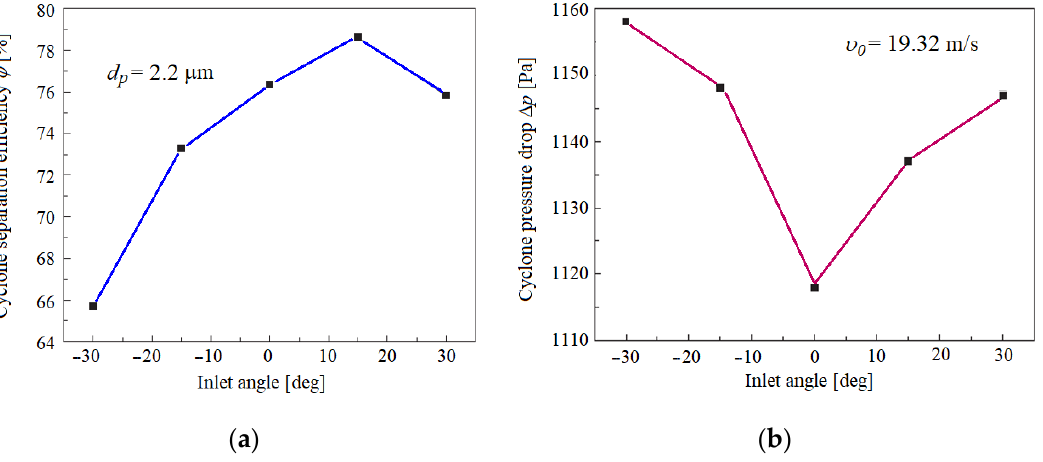
Figure 8. Effect of inlet channel angle of the return cyclone on: ( a ) filtration efficiency and ( b ) cyclone pressure drop. Figure made by the author based on data from paper [68].